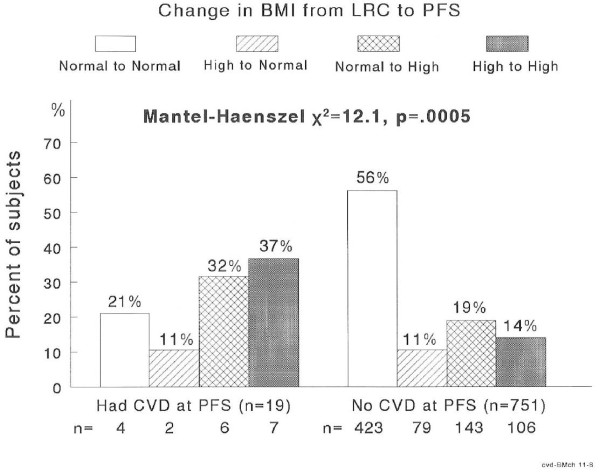
Changes in BMI status groups from childhood to adulthood by adult CVD status.